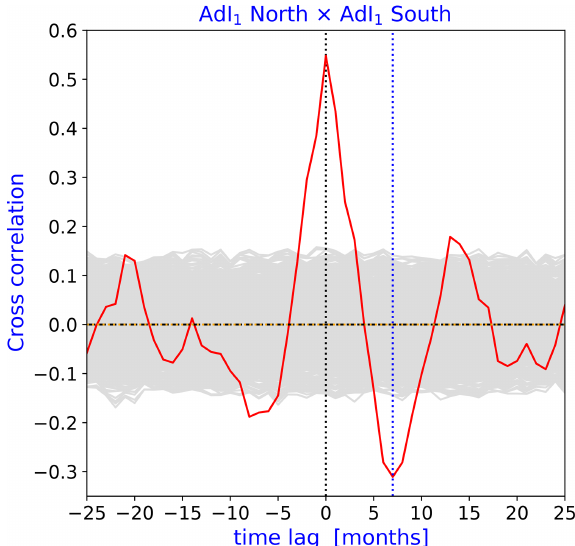
Figure 3. Cross-correlation between the monthly advection index AdI 1 for the northern and southern subsets of advected parcels (red). Dashed blue/black line indicates the time lag at which the cross-correlation is at its absolute minimum / maximum. The gray band indicates the 99% confidence interval, as described in Sect. 2.